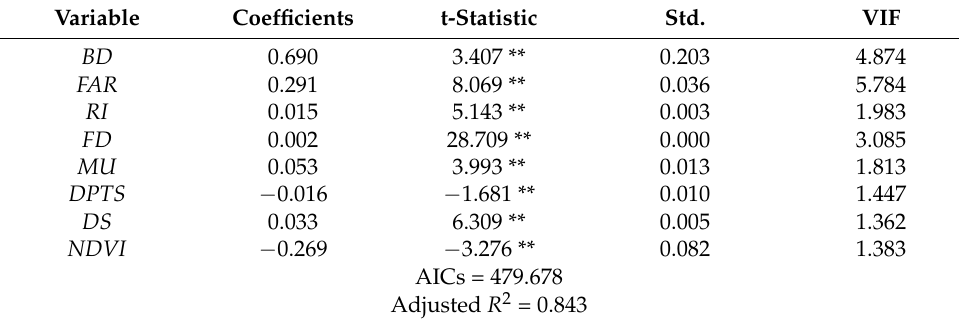
Table 4. Regression results of urban vitality by OLS model on